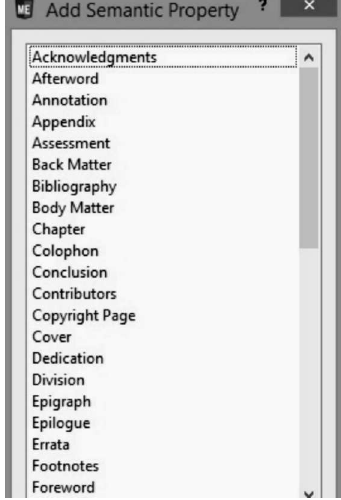
Figure 3. Window of semantic